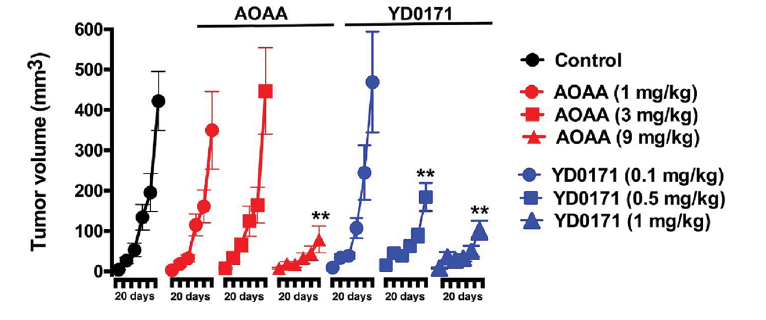
Figure 14. Efficacy of YD0171 in tumor-bearing mice. Comparison of the effect of AOAA or YD0171 on HCT116 tumor growth in nude mice. AOAA inhibited tumor growth at 9 mg/ kg/d (but not at lower doses of 3 or 1 mg/kg/d), while YD0171 exerted an inhibitory effect at 0.5 and 1 mg/kg (but not at the lowest dose of 0.1 mg/kg). Data are shown as mean ±